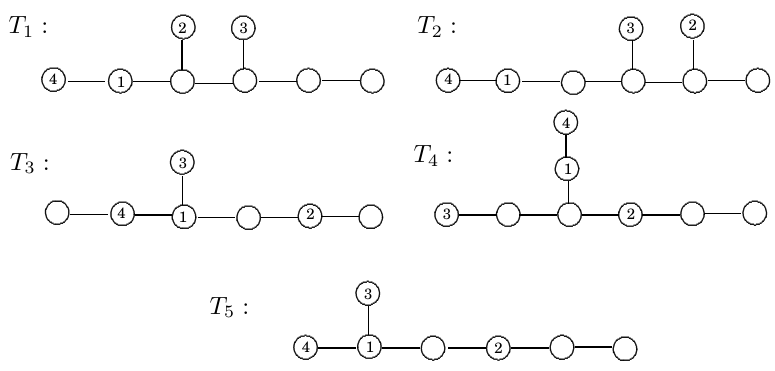
Figure 8: Minimal trees in a tree T with diam( T ) = 5 and ˜ γ ( T ) = 4